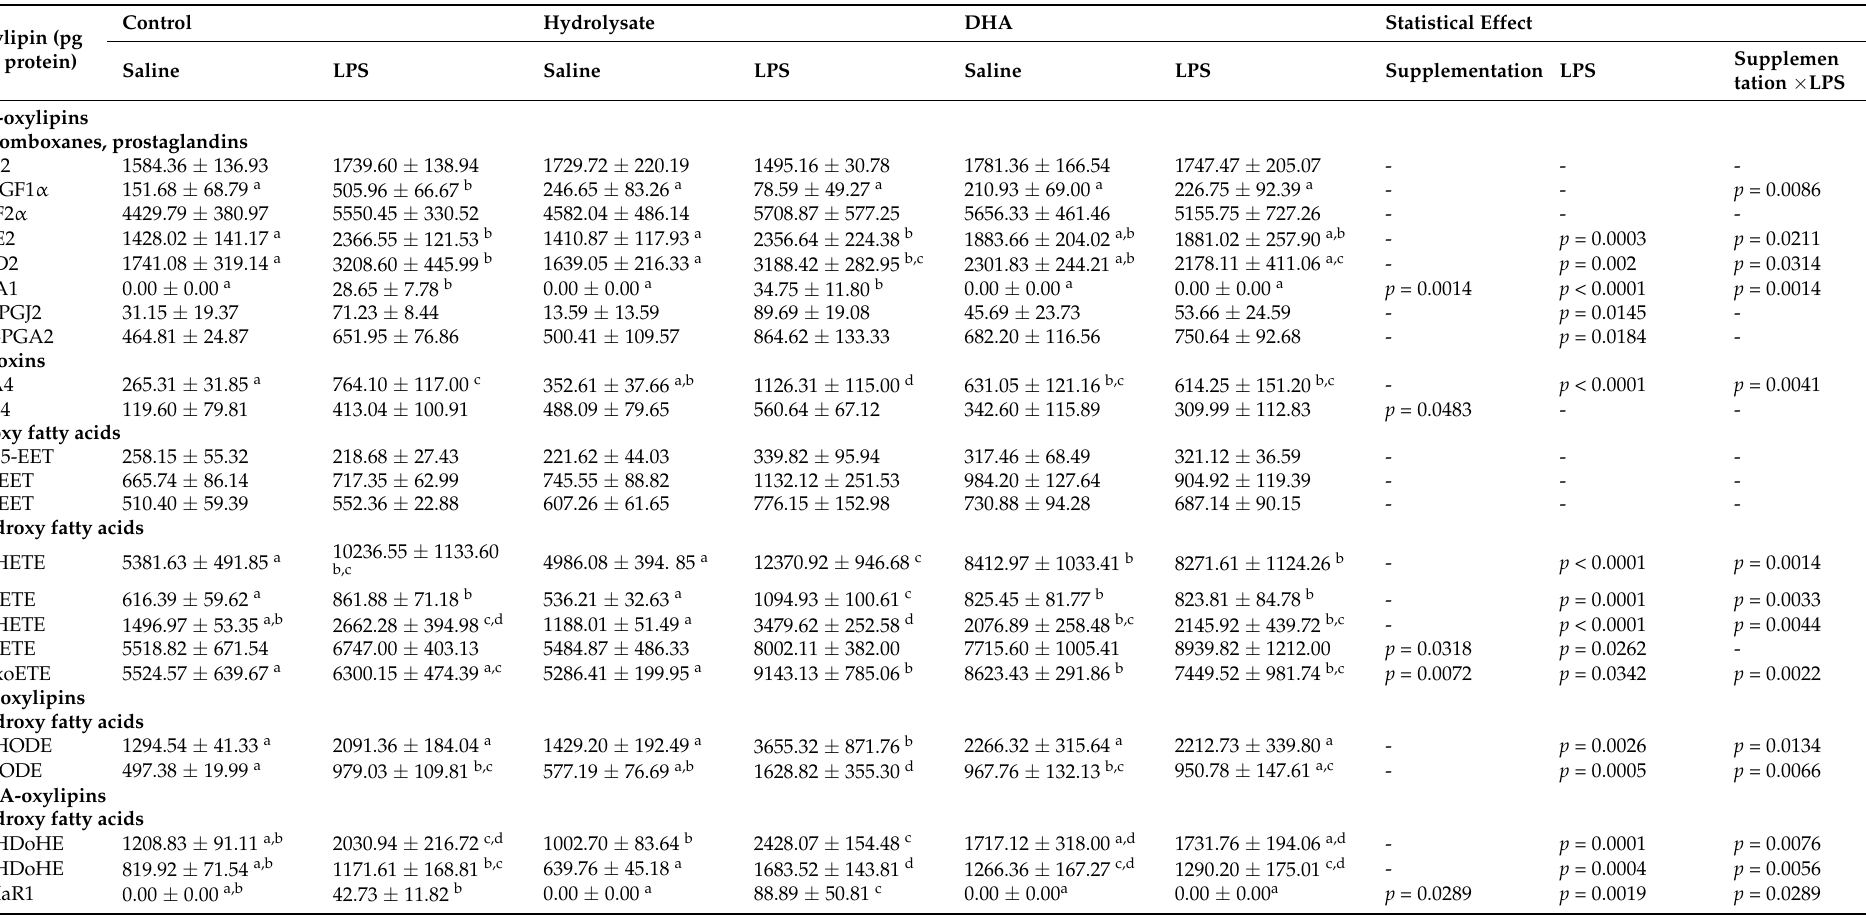
Table 3. Hippocampal oxylipin concentration of mice fed orally with control solution, fish hydrolysate or DHA by daily gavage for 18 days, 2 h following LPS injection (125 µ g/kg). Oxylipin (pg /mg